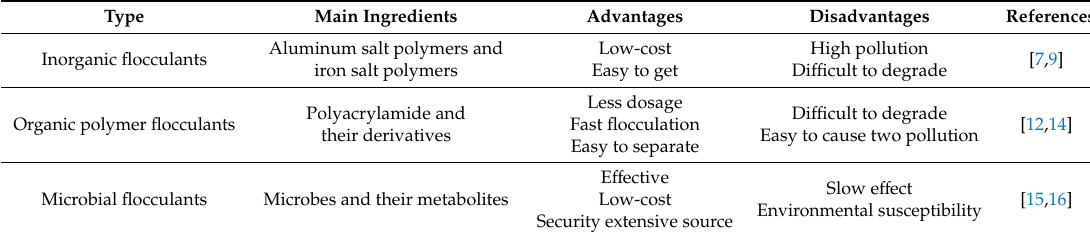
Table 1. Advantages and limitations of three types of